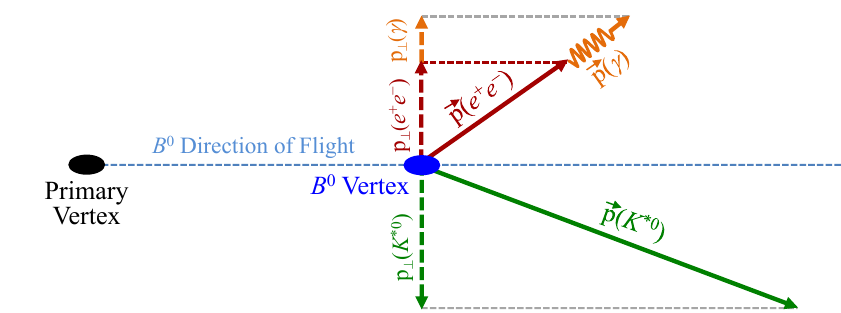
Figure 3 . Sketch of the topology of a B 0 ! K (cid:3) 0 e + e (cid:0) decay. The transverse momentum lost via bremsstrahlung is evaluated as the di(cid:11)erence between the p T of the K (cid:3) 0 meson and that of the dielectron system, where both are calculated with respect to the B 0 meson direction of (cid:13)ight. Bremsstrahlung photons that are not recovered by the reconstruction are assumed to follow the dielectron momentum